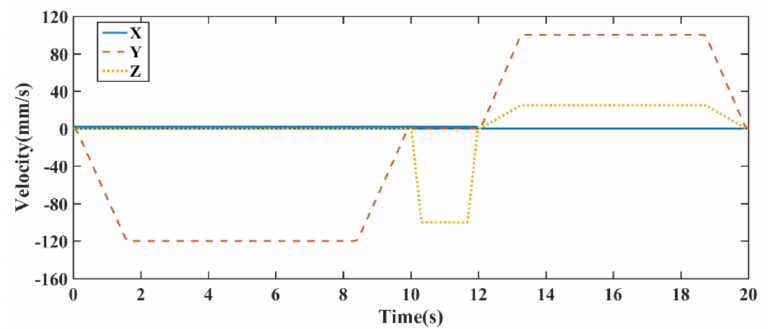
Figure 7. Velocity curve of the end